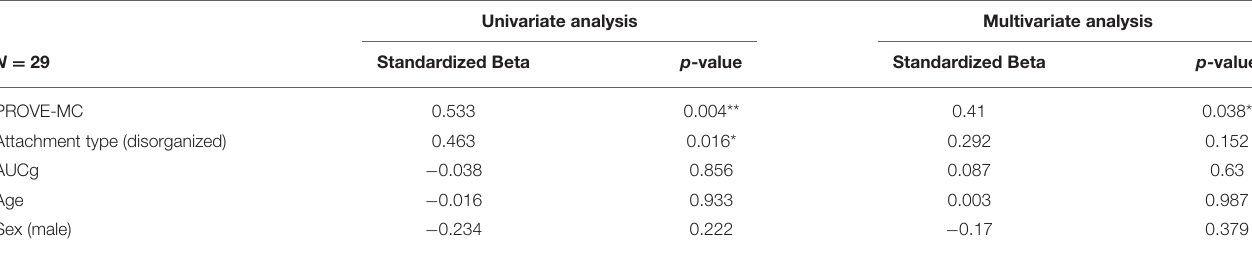
TABLE 5 | Linear regression analysis of depression score in subjects with ACE.